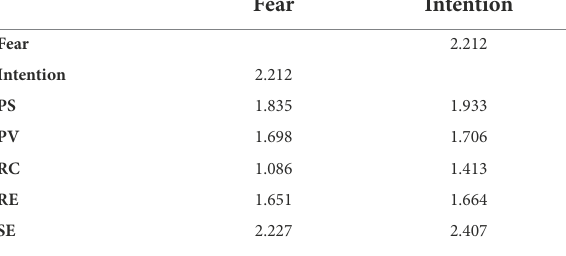
TABLE 5 Inner VIF values for the measuring